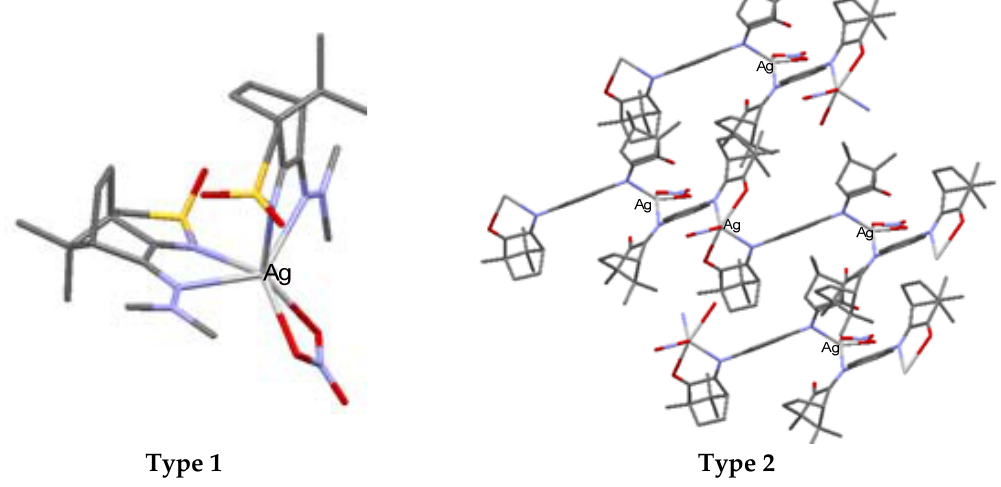
Figure 3. Structural arrangements corroborated by X-ray analysis in Ag(I)-camphor-derived complexes. The synthesis of the Ag(I) camphor complexes includes the preparation of suitable camphor compounds to be used as ligands, since just a few imine functionalized camphor derivatives are commercially available (e.g., camphor oxime and camphor sulphonylimine). (1 R )-(+)-camphor is the starting material for the camphor compounds of type A1–A5 (Figure 4).